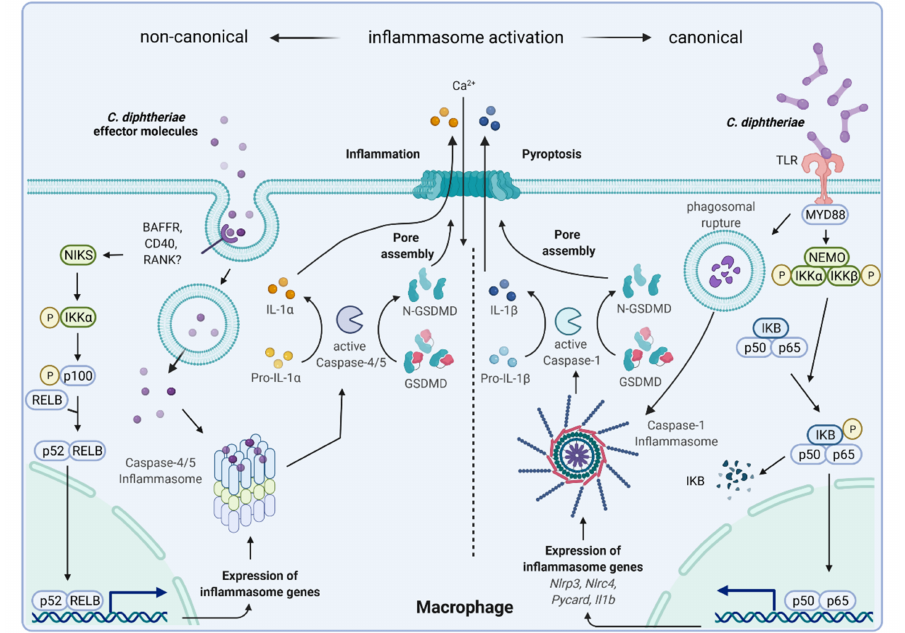
Figure 8. Hypothetical C. diphtheriae -induced non-canonical and canonical inflammasome activation and pyroptosis. Inflammasomes are multimeric proteins that play a pivotal role in host defense